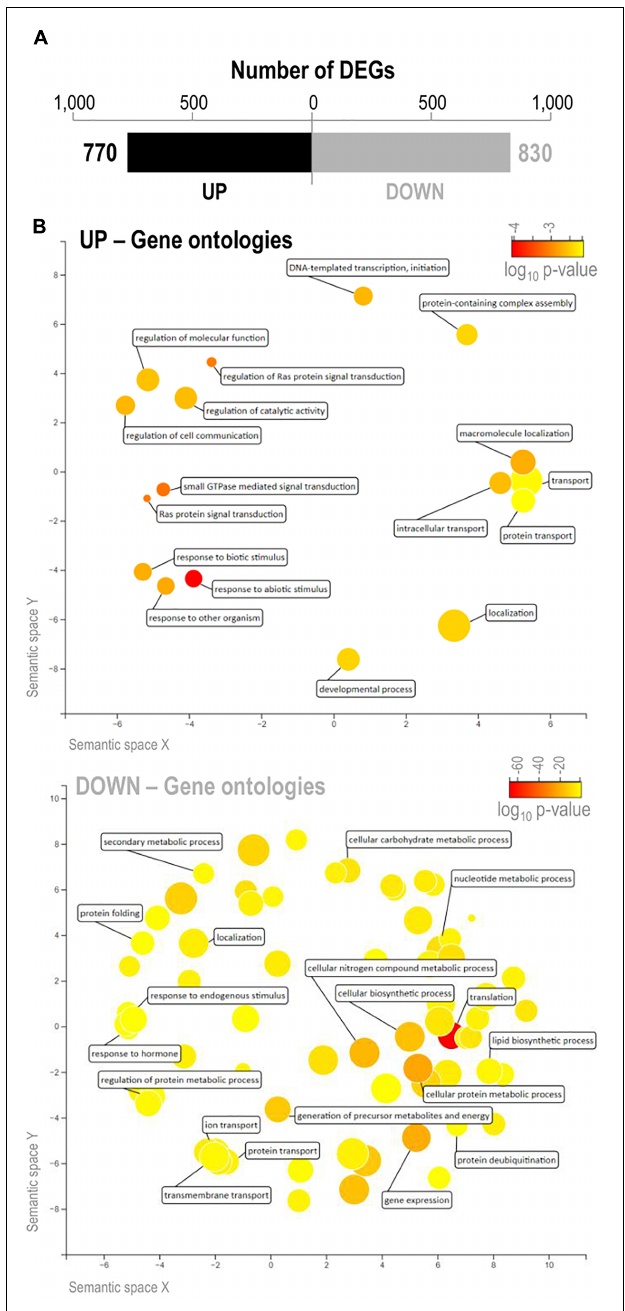
FIGURE 6 | Differentially expressed genes in leaves of IL22 plants relative to OLESA plants. Plants grown in hydroponic culture under control conditions as indicated in Figure 2 . Leaves of 2-week-old plants were used for RNA-Seq analysis. (A) Number of DEGs (black, up-regulated genes; gray, down-regulated genes). (B) Biological processes altered in IL22 plants relative to OLESA plants. GO terms enriched in up- and down-regulated genes in IL22 plants were visualized by REVIGO (Supek et al., 2011). The most enriched GO terms in the set of up-regulated and down-regulated genes are presented (upper and lower panels, respectively). Circles represent GO terms and those clustered closer to each other indicate similar GO terms. Color scale (yellow to red) represents the degree of GO enrichment (log 10 P -value). Larger and smaller disc size represent more general and more specific terms,